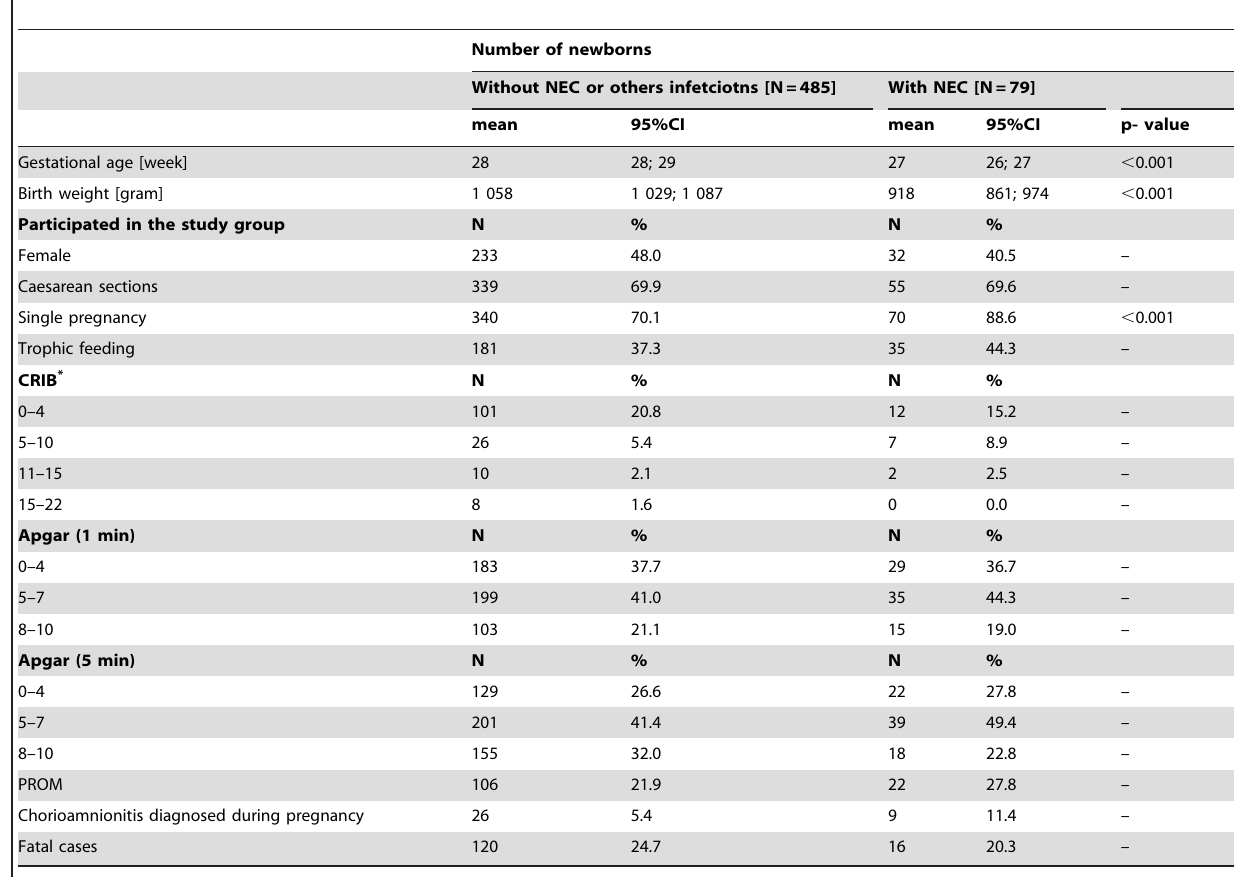
Table 1. Characteristics of neonates with symptoms of NEC and newborns without signs of any infections.